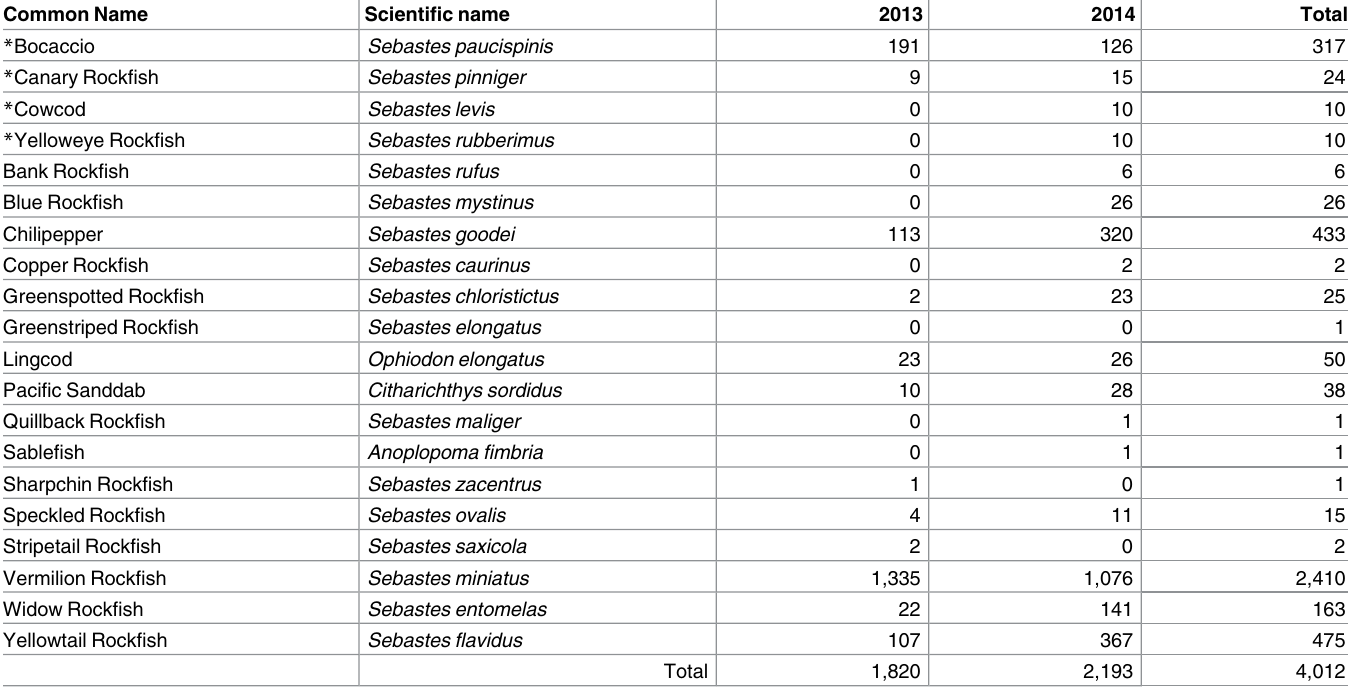
Table 4. Weight (kg) of individual species caught and landed in fishing